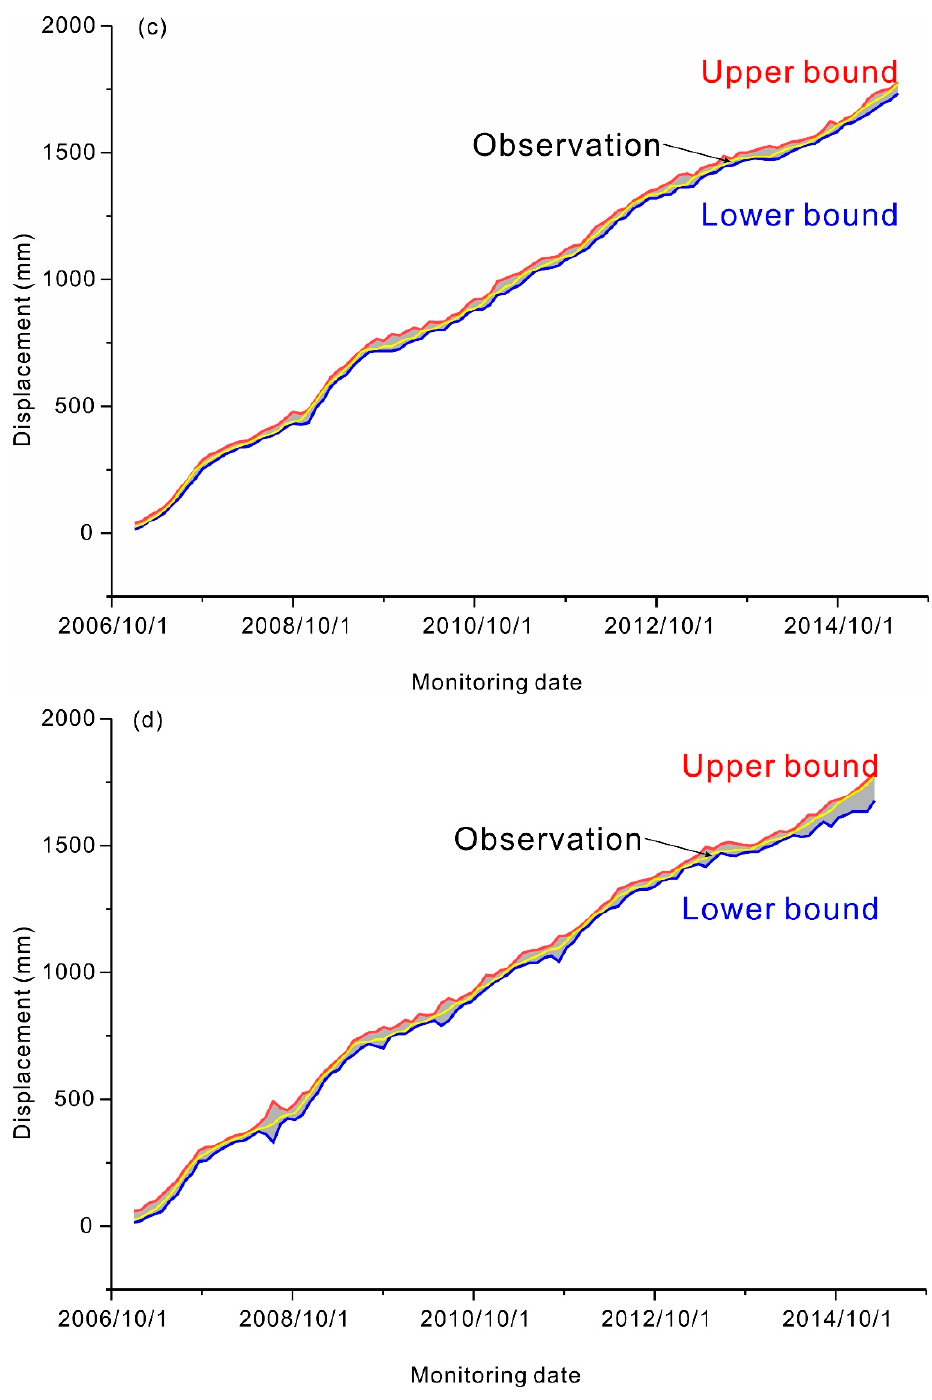
Figure 10. Comparisons of the observations and the constructed PIs at a 90% confidence level for the Fanjiaping landslide at ZG289 and ZG291 using QRNNs-KDE and bootstrap-ELM-ANN. ( a ) 90% PIs at ZG291 using QRNNs-KDE; ( b ) 90% PIs at ZG291 using bootstrap-ELM-ANN; ( c ) 90% PIs at ZG289 using QRNNs-KDE, ( d ) 90% PIs at ZG289 using bootstrap-ELM-ANN.